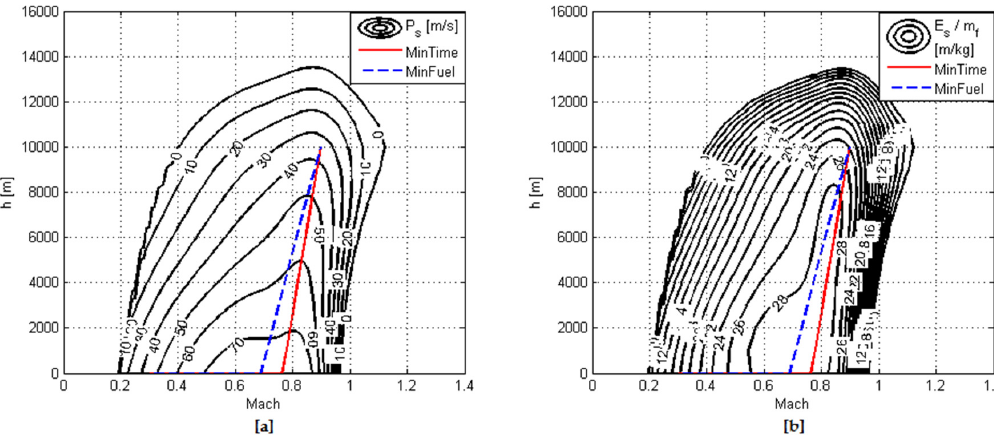
Figure 14. Case A, Configuration C2; Minimum Time and Minimum Fuel climb paths, plotted over contours of: Specific Excess Power (m/s) ( a ); and Energy Efficiency (m/kg) ( b ).